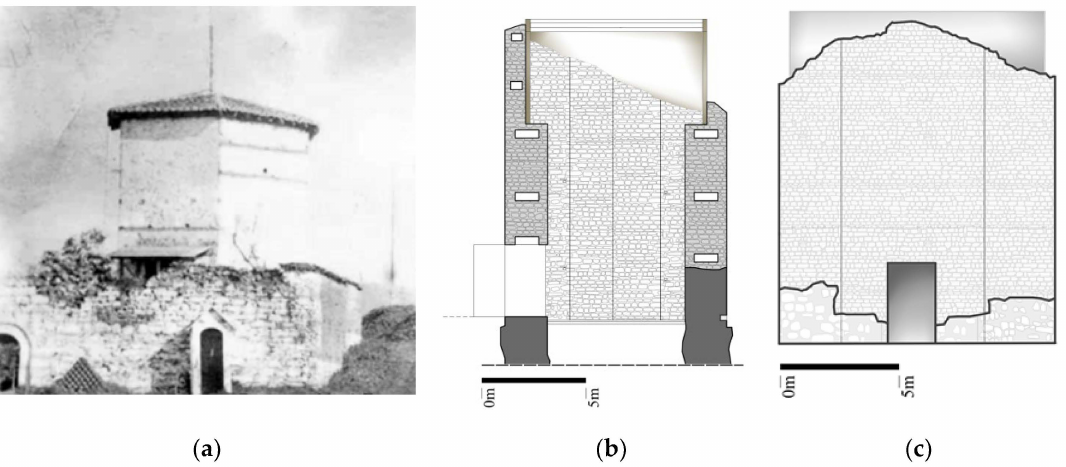
Figure 25. Tower Dzephana. ( a ) Tower Dzephana before the demolition, called Ahmed Aga’s tower (It is assumed that he rebuilt it) (Photo source: private archive of Vladan Vidosavljevi´c). ( b ) Cross- section of the tower Dzephana—proposal. ( c ) Detail of the materialization of the façade—proposal (Drawigns: Lejla